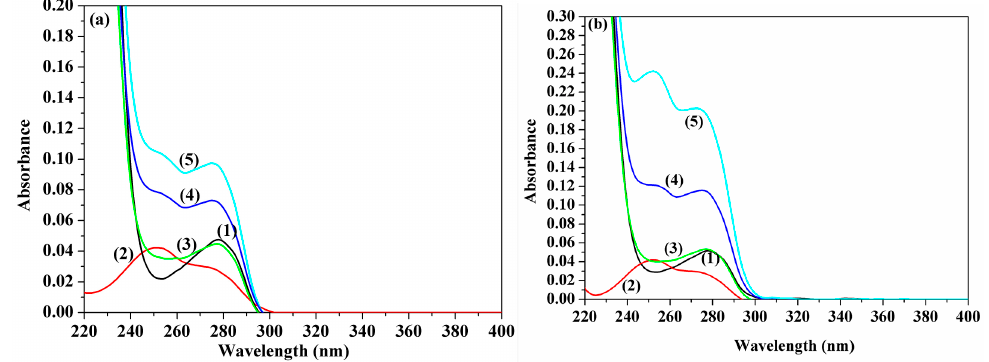
Figure 6. UV-Vis absorption determinations. Panel ( a ) shows ACV-HSA showing spectra of: (1) 1.5 μ M HSA, (2) 7 μ M ACV, (3) HSA subtracted from ACV complex, (4) 7 μ M ACV + 1.5 μ M HSA and (5) 15 μ M ACV + 1.5 μ M HSA. Panel ( b ) shows PNV-HSA showing spectra of: (1) 1.5 μ M HSA, (2) 8 μ M PNV, (3) HSA subtracted from PNV-complex, (4) 17 μ M PNV + 1.5 μ M HSA and (5) 35 μ M PNV + 1.5 μ M HSA.